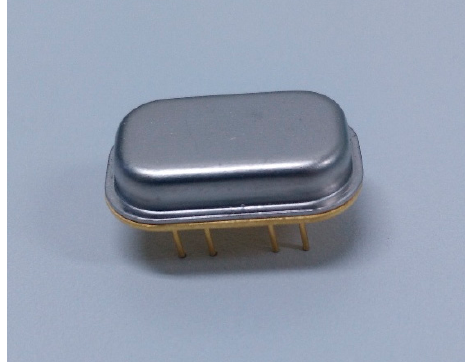
Figure 10. Metal vacuum packaging for the AlN MEMS gyroscope.